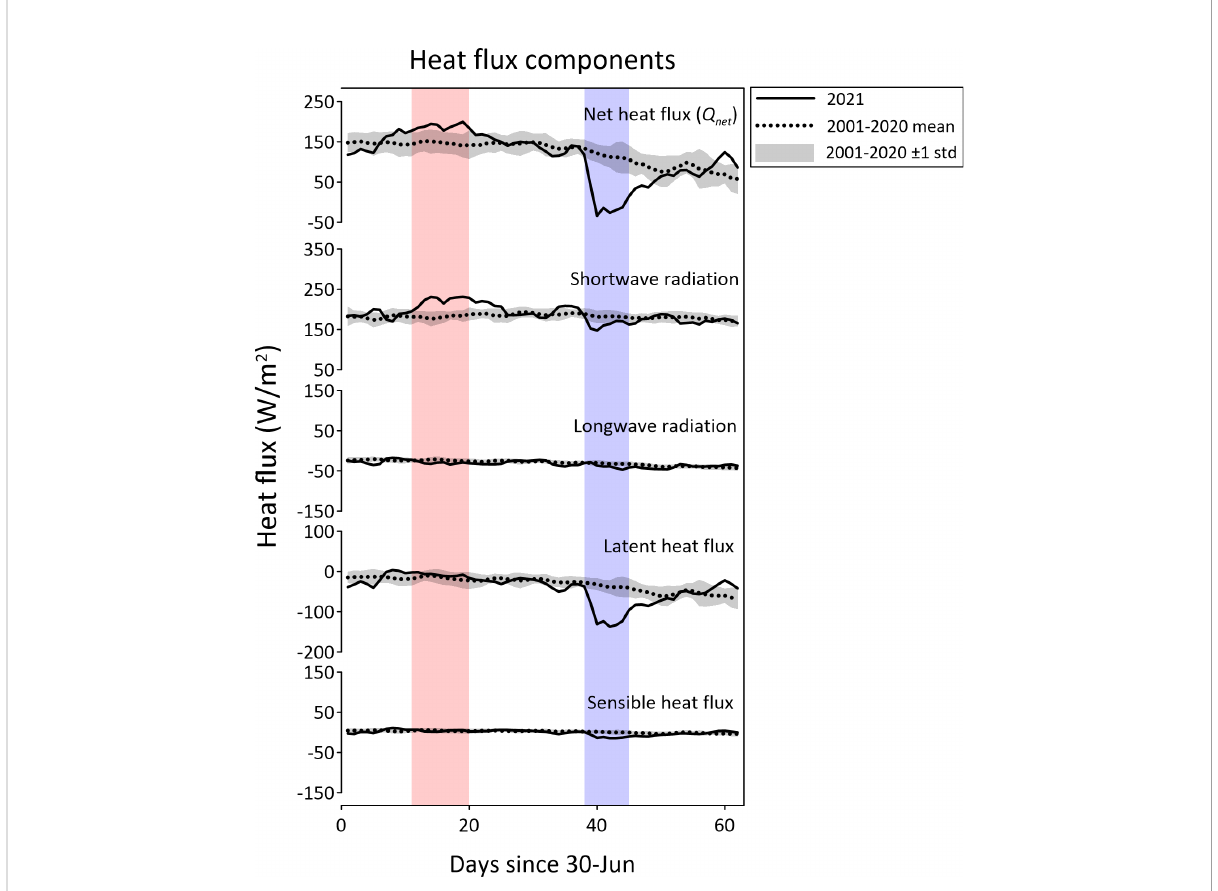
FIGURE 3 Time series plots of the surface net heat fl ux and its components in the total (TOT) mid-latitude in the western North Paci fi c region for 2021 (solid line), climatology for 2001 – 2020 (dotted line), and its typical interannual variability estimated using one standard deviation. Positive indicates downward fl